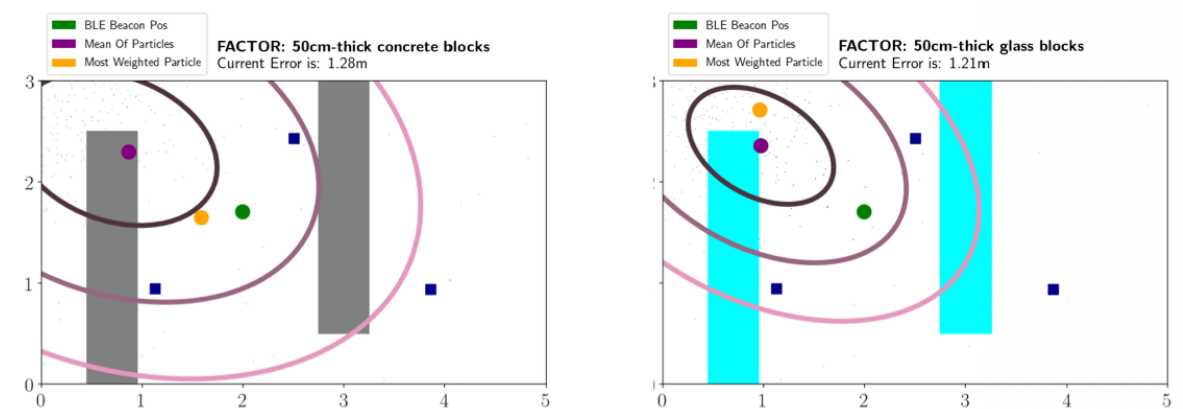
Figure 5. The OASLTool displays the particle filter tracking results in an animated manner. Blue squares show the placement of receivers; the green circle shows the actual position of the tag; the orange circle is the particle with the maximum weight; the purple circle is the weighted mean of the particles, which is used as the predicted position. The ellipses visualize the covariance of the